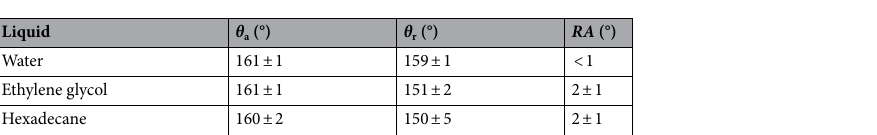
Table 1. Average values with standard deviations of the apparent advancing ( θ a ) and receding ( θ r ) contact angles as well as the roll-off angles ( RA ) for 10 μL drops of water, ethylene glycol and hexadecane on the superamphiphobic surface, measured with